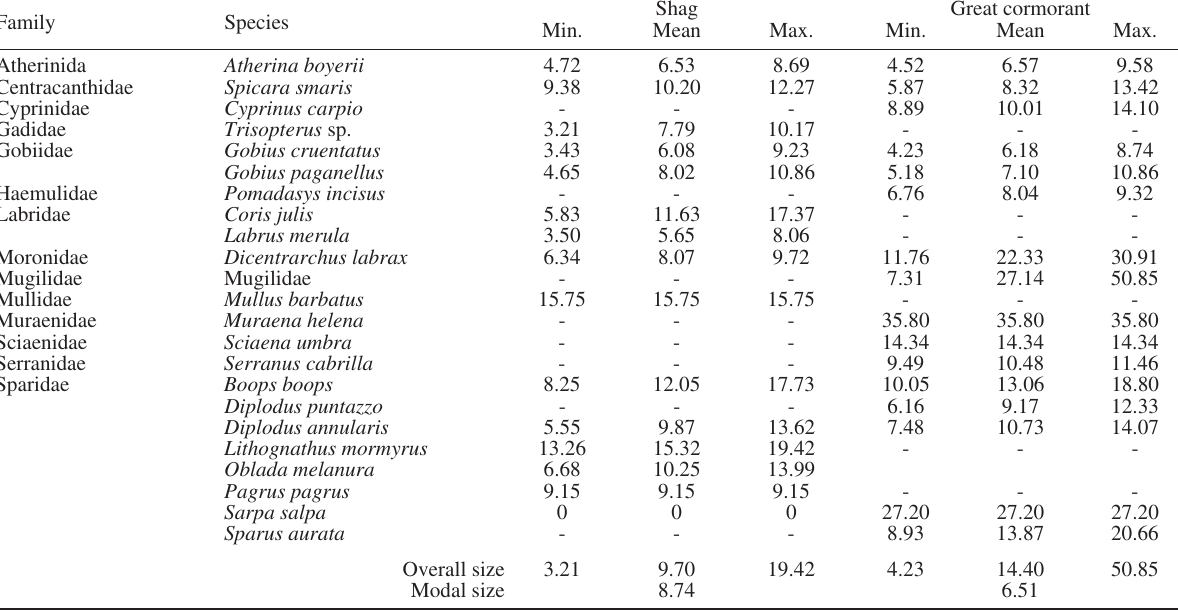
Table 4. – Minimum, mean and maximum size (fork length in cm) of shag and great cormorant preys. Family Species